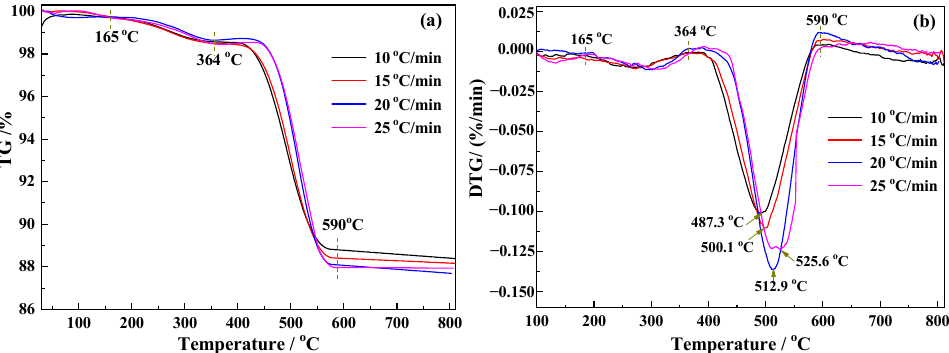
Figure 4. ( a ) TGA and ( b ) DTG curves for the roasting of siderite.